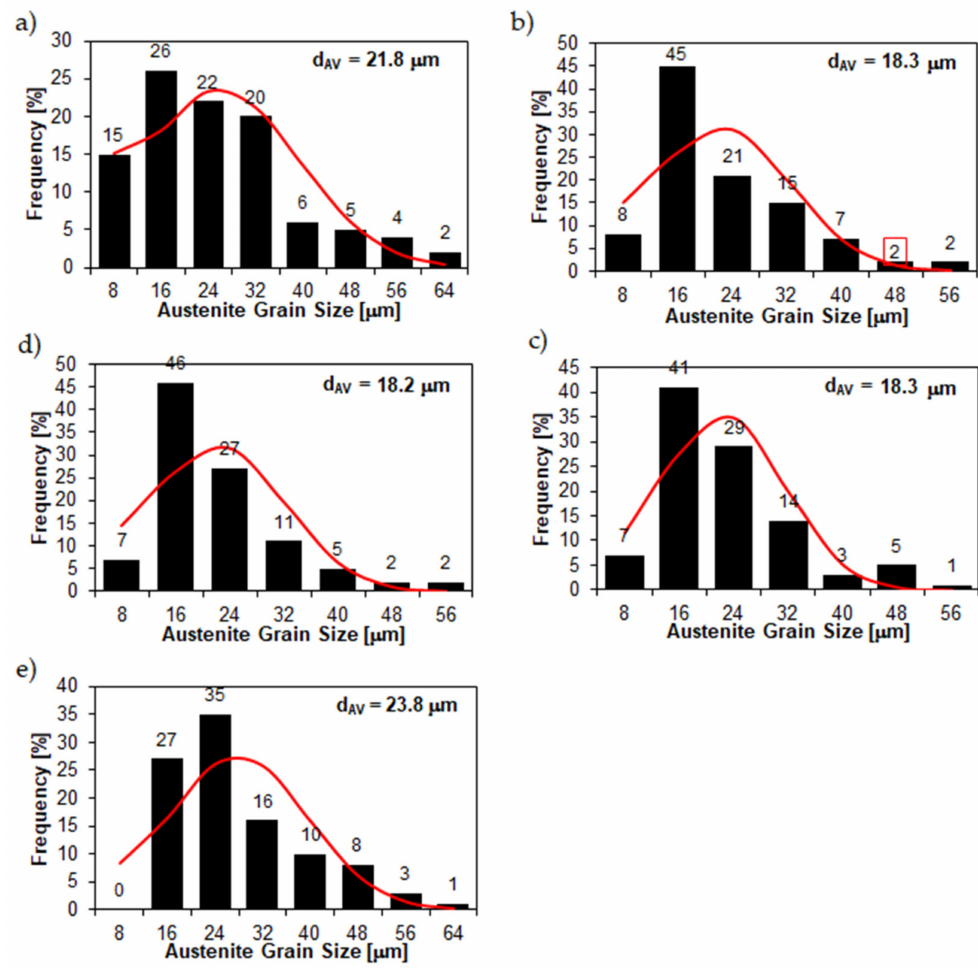
Figure 7. Frequency intervals and the normal occurrence distributions of the determined grain sizes of the prior austenite in the tested types of steels: ( a ) Creusabro 4800; ( b ) Creusabro 8000; ( c ) TBL PLUS; ( d ) XAR 600; ( e ) 38GSA; d AV —average grain